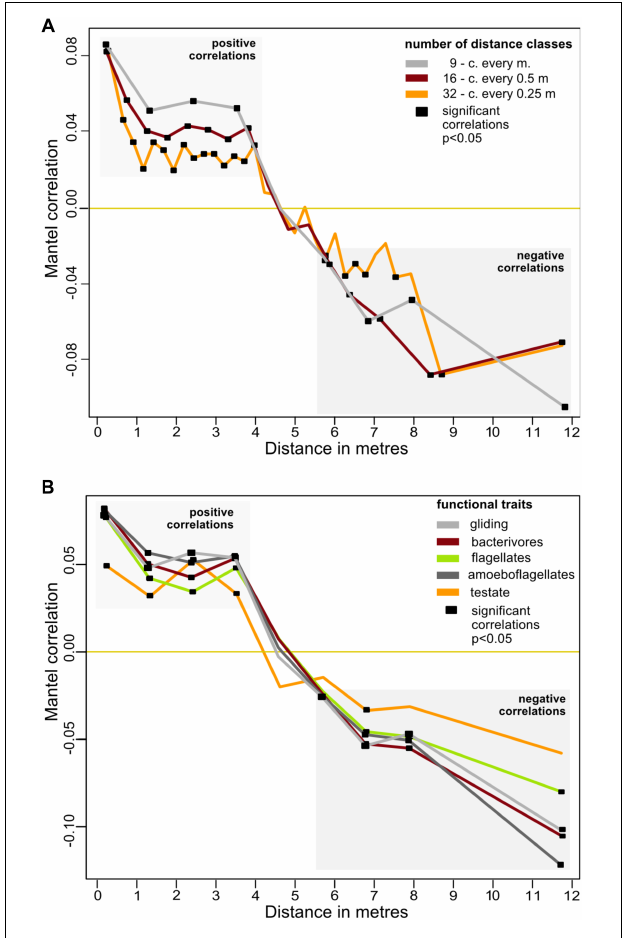
FIGURE 3 | Effect of distance on the beta-diversity of the cercozoan communities. (A) Mantel correlograms based on Bray-Curtis OTUs dissimilarities compared to Euclidian spatial distances and the Spearman correlation coefficient. Three distance classes were considered, resulting in intervals of 0.25, 0.5, and 1 m. Only significant values ( p < 0.05) are highlighted with black squares. Positive correlations were detected at distances from 0.45 to 3.875 m, no correlations at distances between 4.0 and 5.5 m. From 5.5 to 12.4 m, the communities were negatively correlated. (B) Mantel correlograms as above, calculated for OTUs grouped by the most represented functional traits, with nine distance